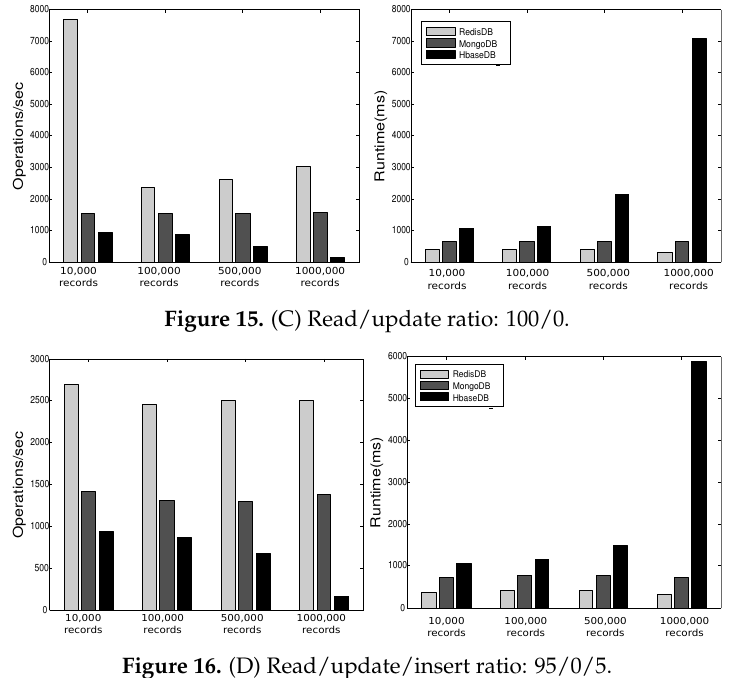
Figure 16. (D) Read/update/insert ratio: 95/0/5.